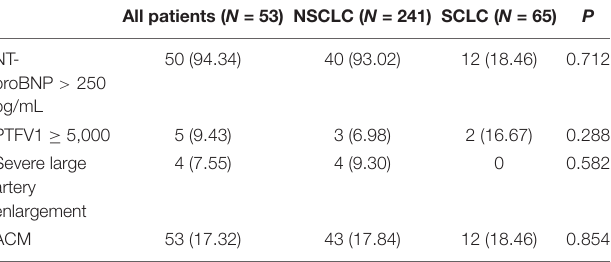
TABLE 3 | Prevalence of ACM in NSCLC vs. SCLC patients.